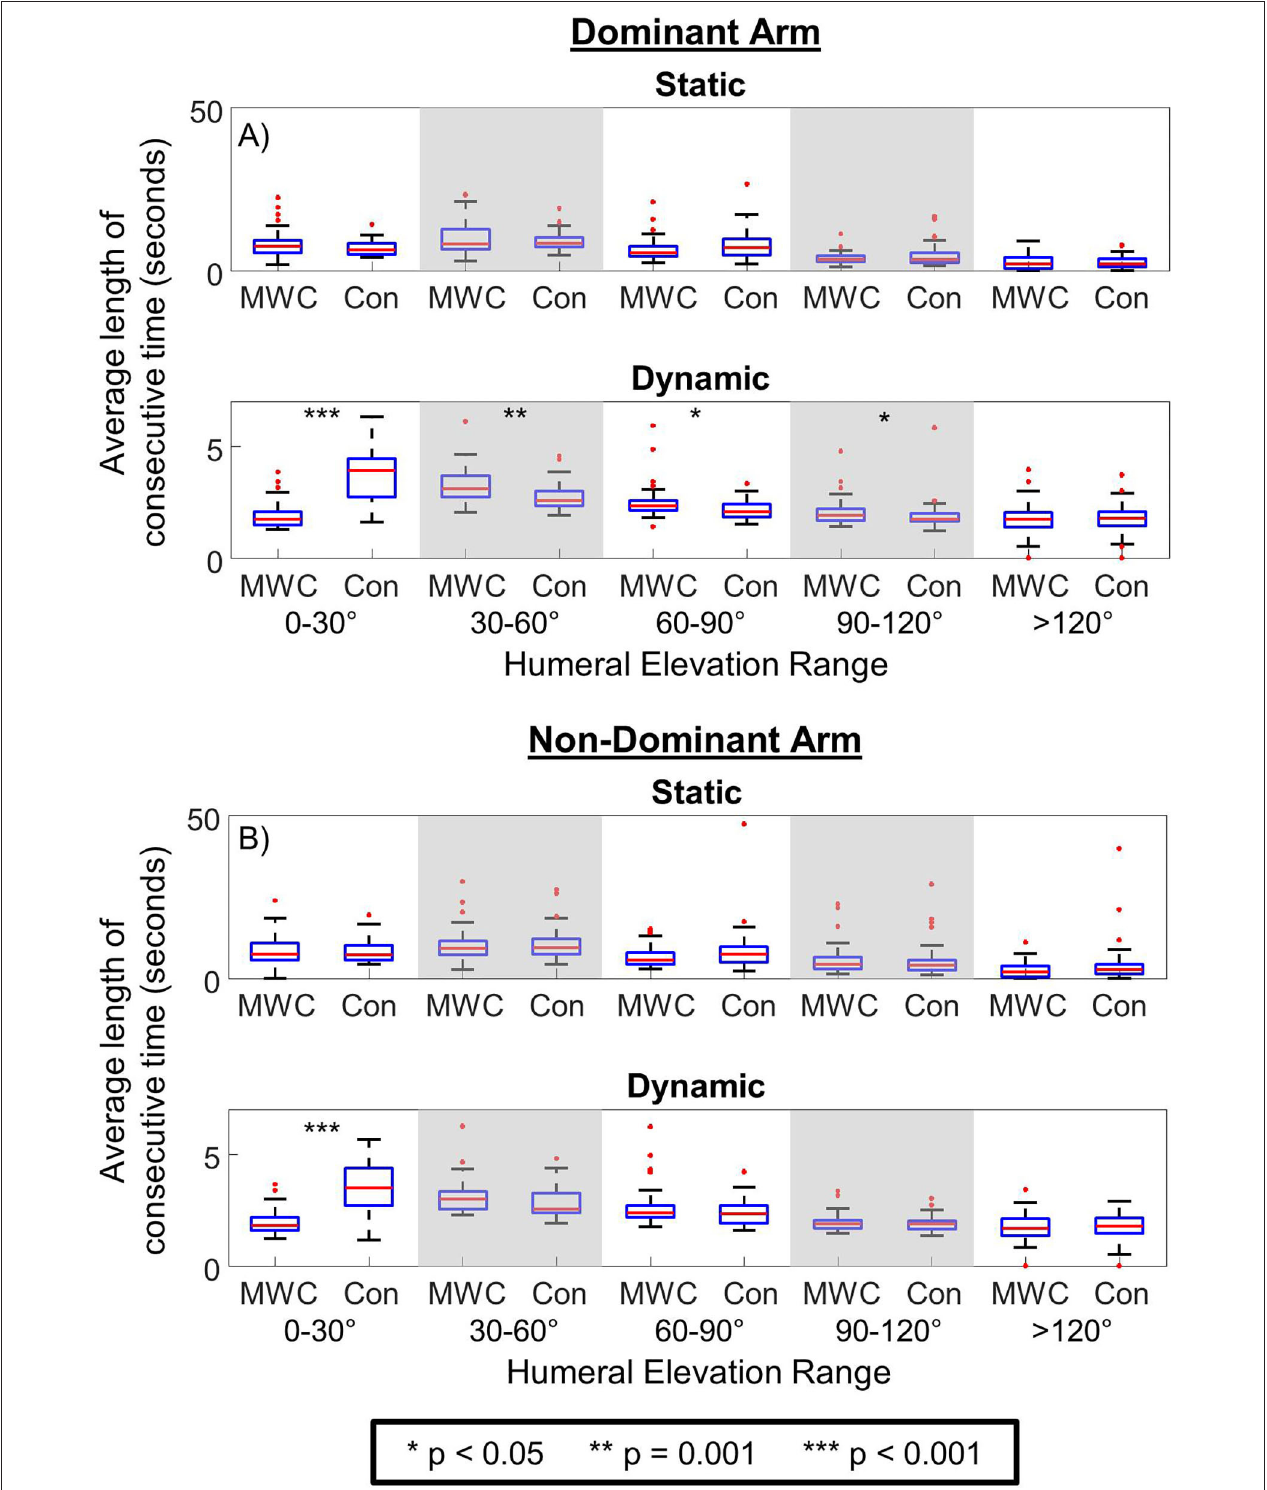
FIGURE 4 | The average consecutive duration of static and dynamic periods in each humeral elevation range for MWC (MWC) and controls (Con) cohorts for the dominant arm (A) and non-dominant arm (B) . * indicates p < 0.05, ** indicates p = 0.001, and *** indicates p < 0.001.